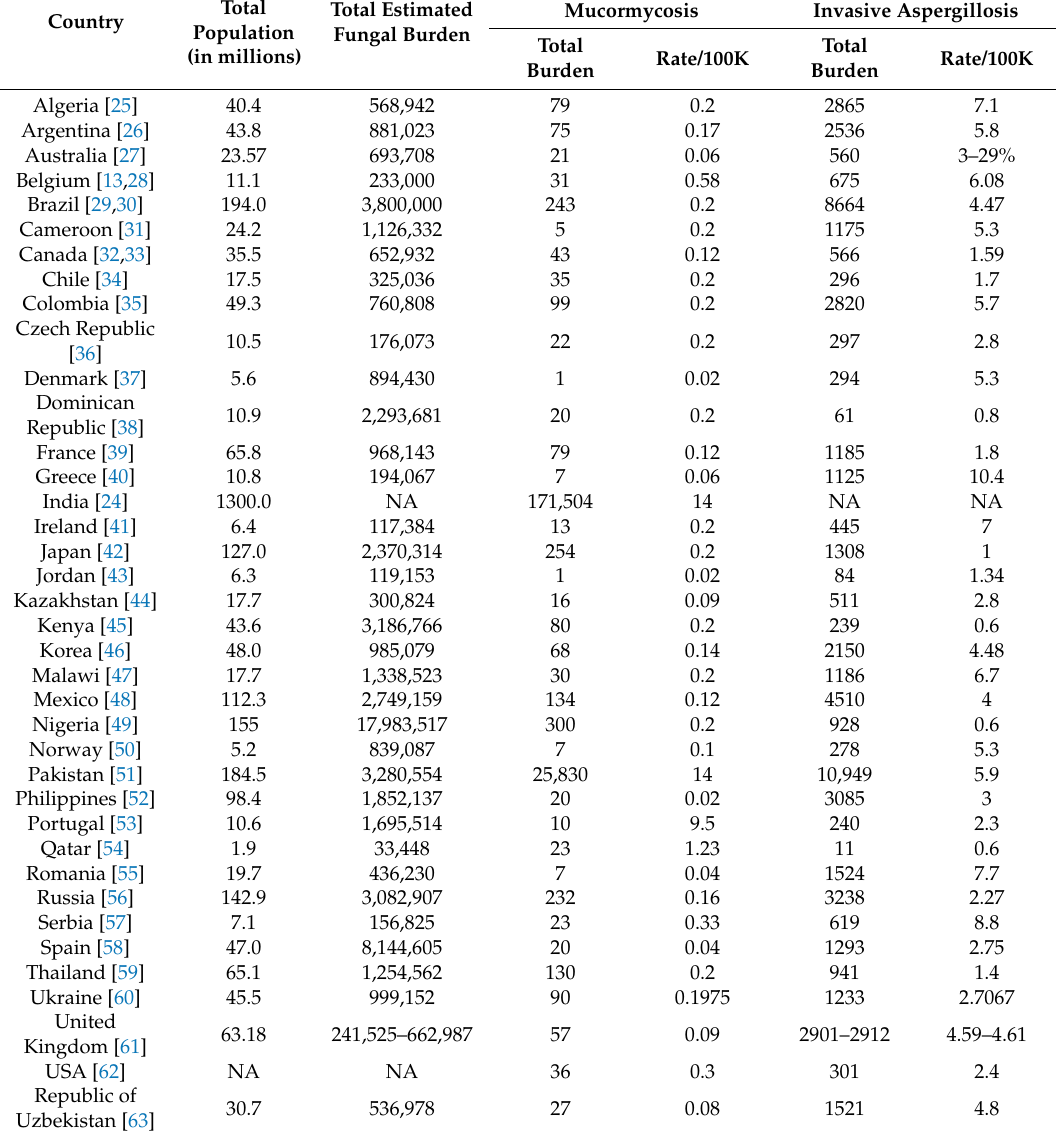
Table 1. The estimated burden of mucormycosis in different